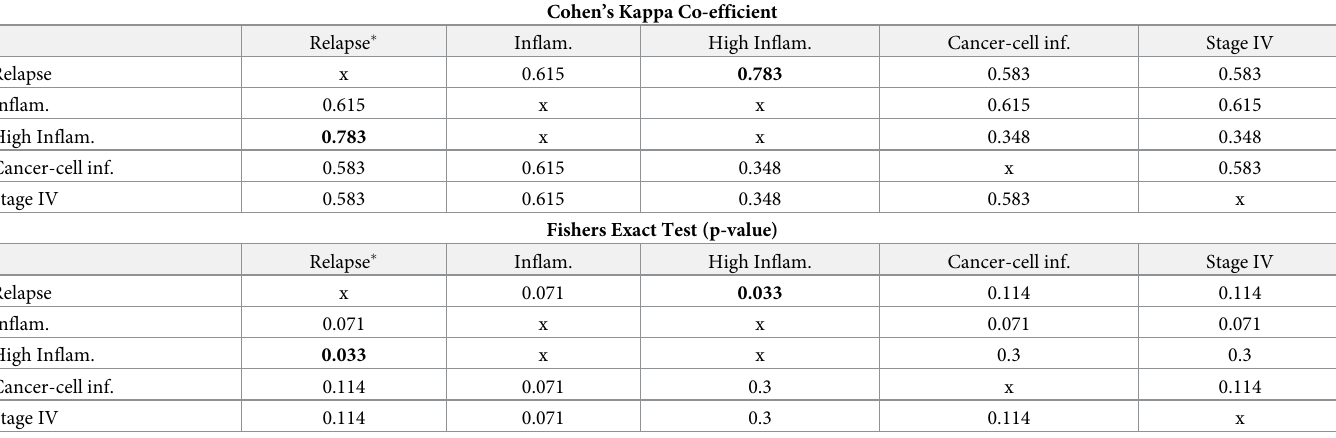
Table 2. Cohen’s Kappa Coefficient for inner-agreement between different sample states (1 = perfect agreement) and Fisher’s exact test for identification of signifi- cant non-random association (p < 0.05) (n = 10).